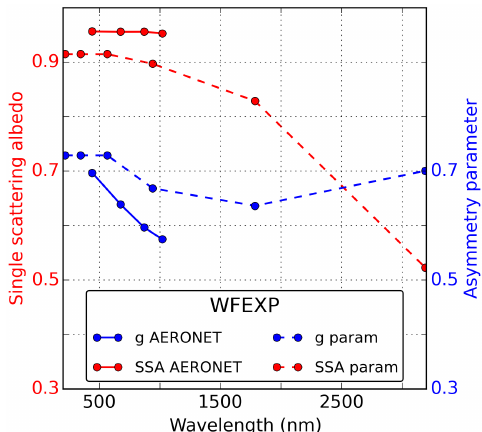
Figure 3. Single scattering albedo (SSA, red continuous) and asym- metry factor ( g , blue continuous) at Tõravere on 8 August 2010, as a function of wavelength, attained from the AERONET inversion products database. The data are averaged over the day – data at three different times were available and the time dependence was small. The parameterised SSA and g for the six IFS SW bands (points are plotted at the midpoint between each of the bands) are depicted by the dashed lines. Both observed and parameterised SSA and g values are spectrally averaged for use by the hlradia and acraneb2 radiation